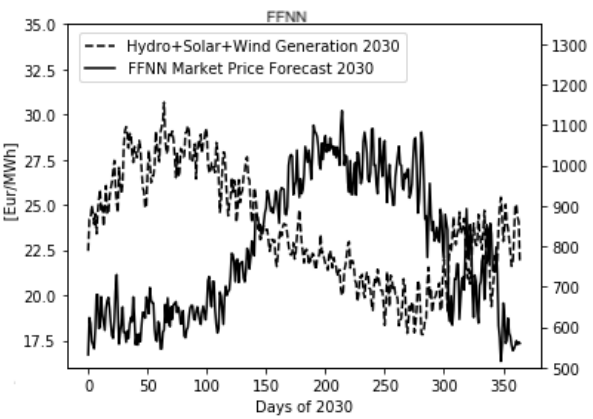
Figure 7. Forecasted FFNN electricity prices versus hydro, solar, and wind power generation (renewables) for 2030 in MIBEL.